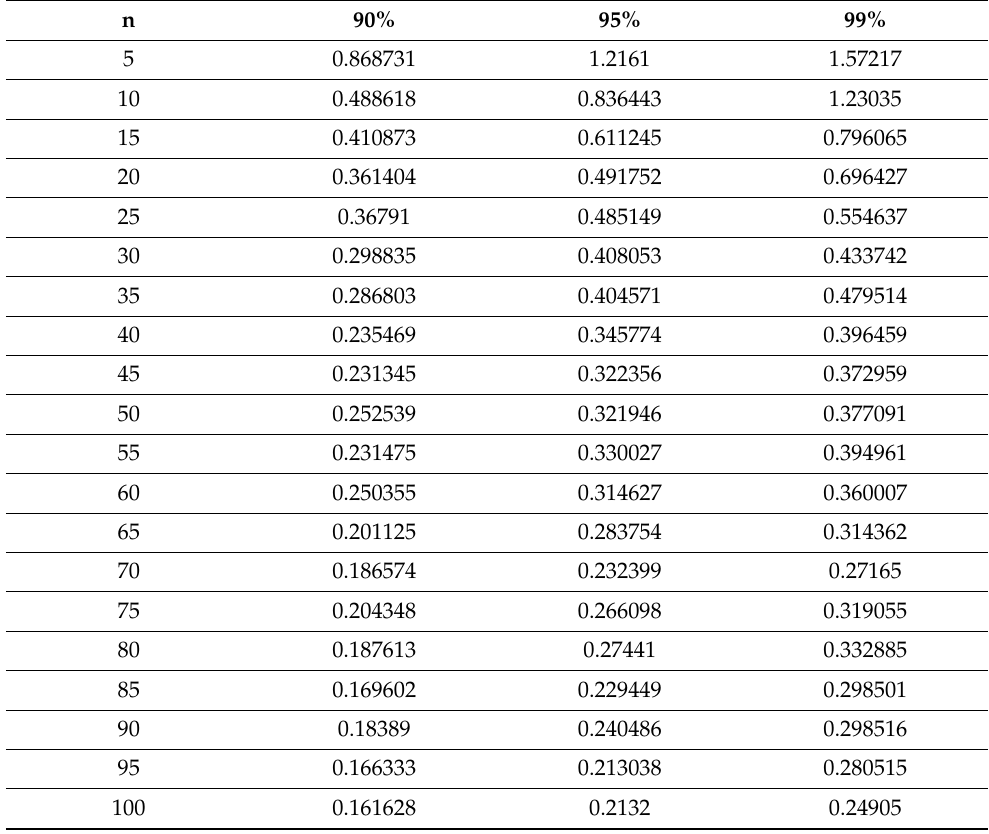
Table 1. The Higher Percentile Values of ˆ δ n ( 0.09 )